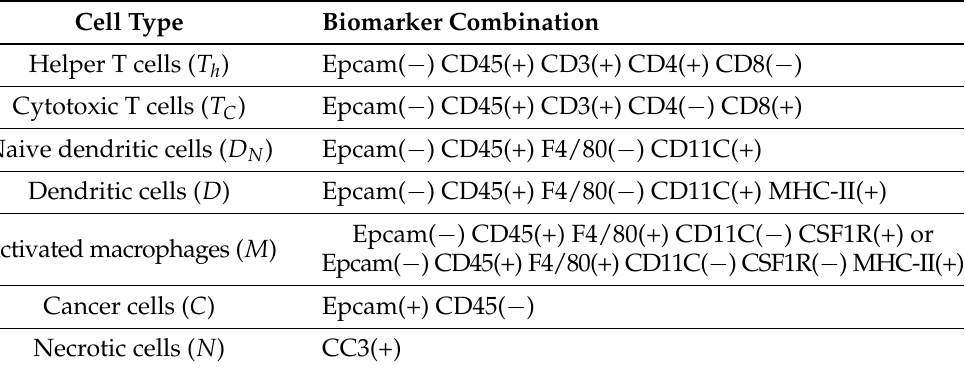
Table 2. Biomarker combinations. (+) means high expression and ( − ) means lack of expression of a protein at a certain